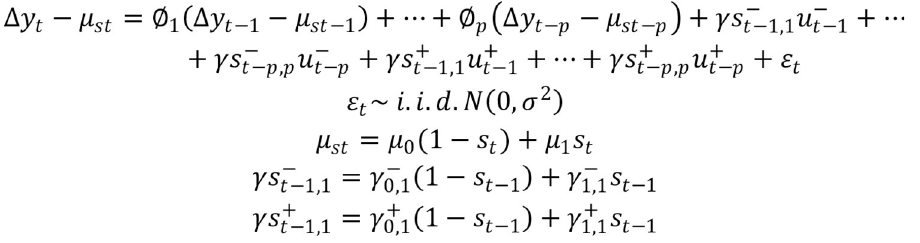
Fig 4. Specification of the Markov-switching